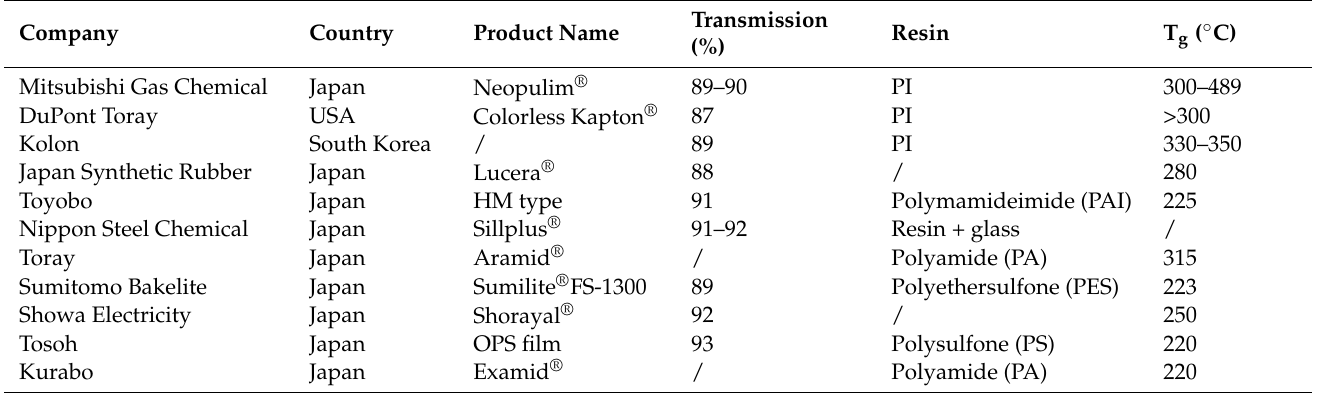
Table 1. Several commercial high-performance optical polymer films worldwide [60].